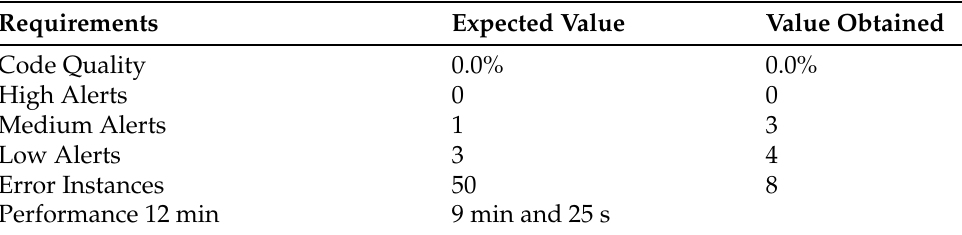
Table 2. List of Java Prototype KPI